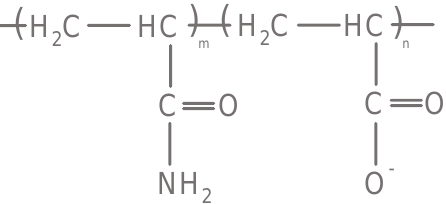
Figure 3. Molecule of a partially hydrolyzed polyacrylamide (modified after Zhu et al. [46]) .